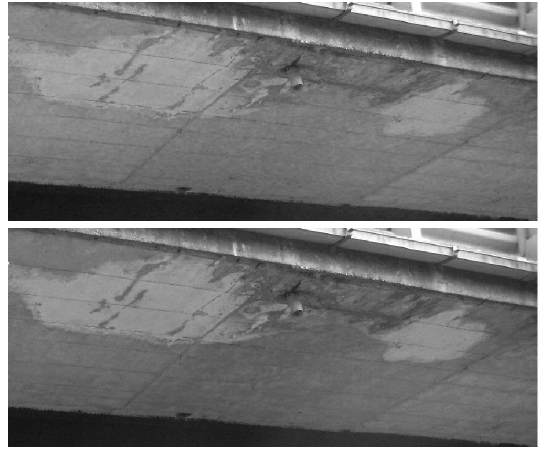
Figure 2: Red (top) and green (bottom) color channels for the image in Fig. 1. Brighter pixels are associated to higher values of the considered variables.